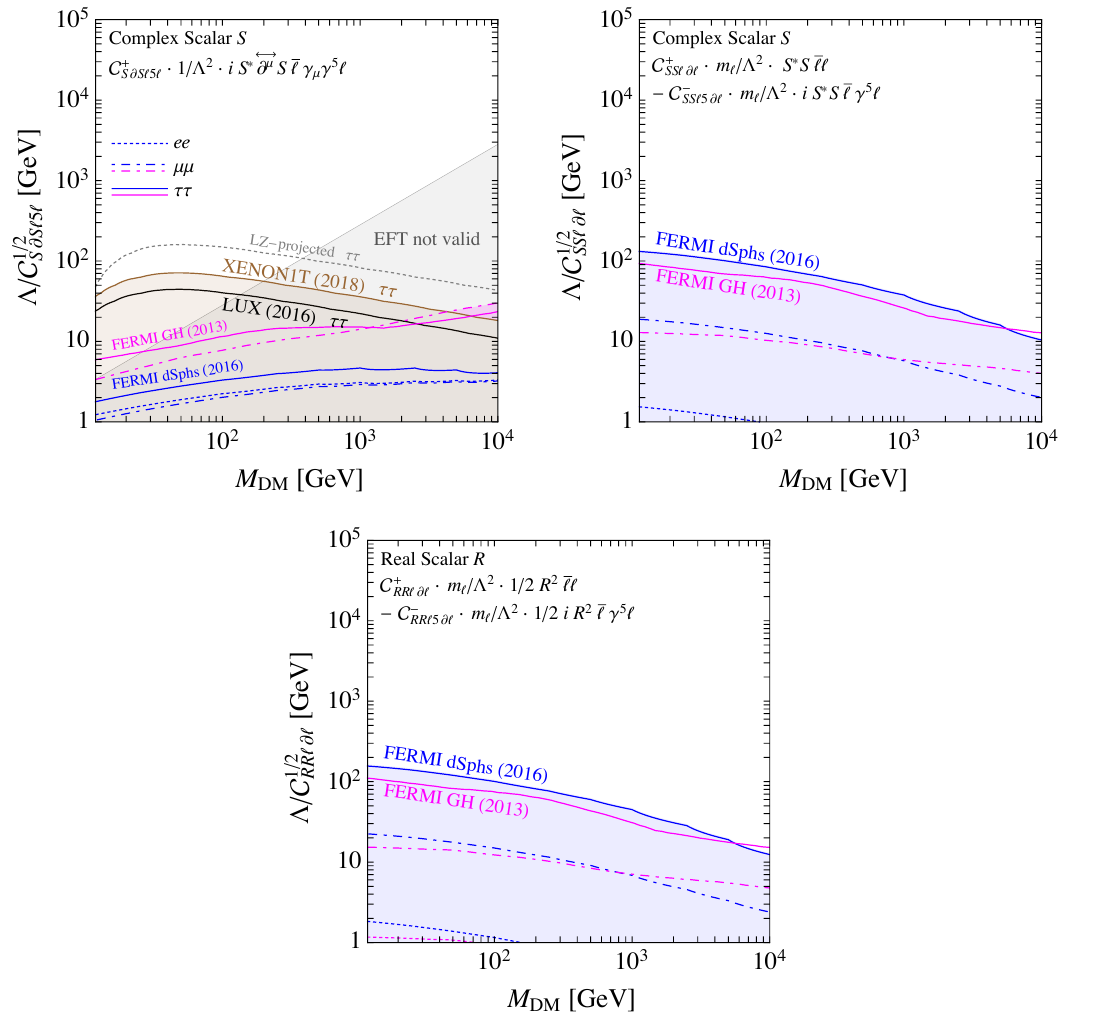
Figure 6 . Same as (cid:12)gure 4 but for the UV-related operators for complex (top) and real (bottom) Scalar DM. These constraints should be compared with the corresponding constraints from DM- photon operators shown in (cid:12)gure